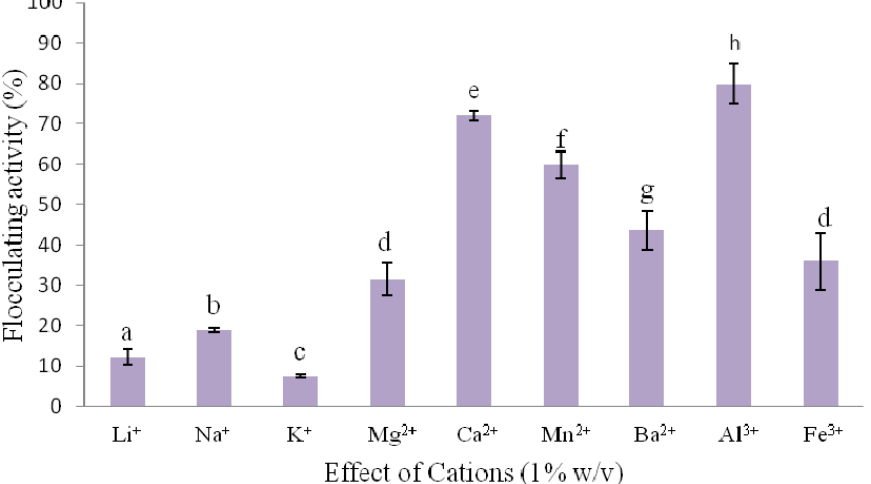
Figure 3. Effect of cations on the flocculating activity of the bioflocculant produced by a consortium ( Halomonas sp. Okoh and Micrococcus sp. Leo). Flocculating activities with different letters are significantly different ( p < 0.05) from each